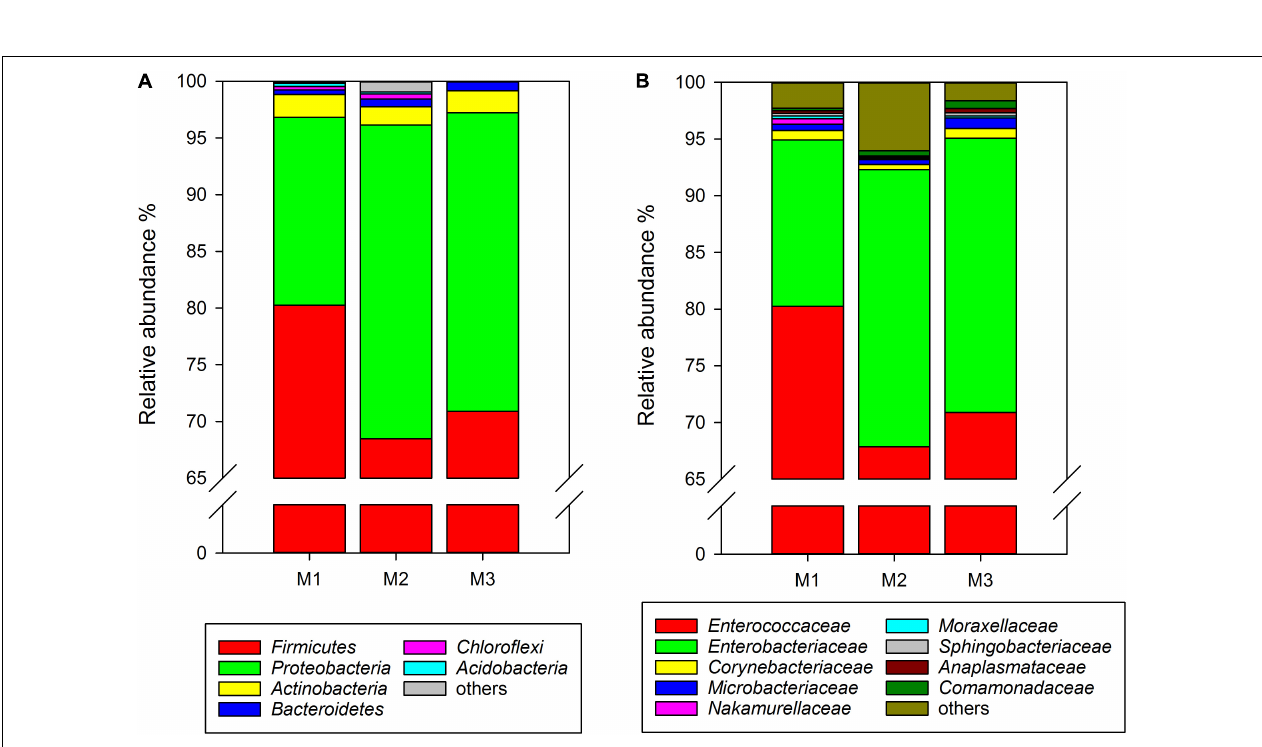
FIGURE 2 | Relative abundance of the gut microbiota from maize-feeding C. medinalis for three generations at the phylum (A) and family (B) levels. M1–M3: the first to third generation of C. medinalis fed on maize.